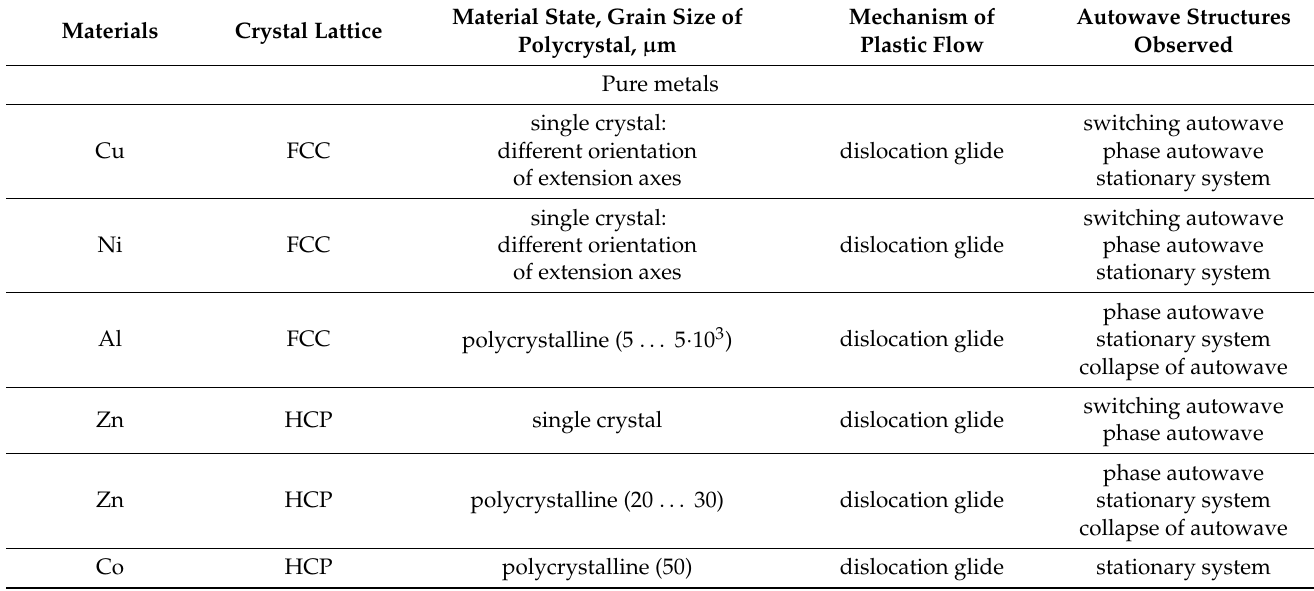
Table 1. The test materials and the main data on deformation localization autowaves obtained for the same